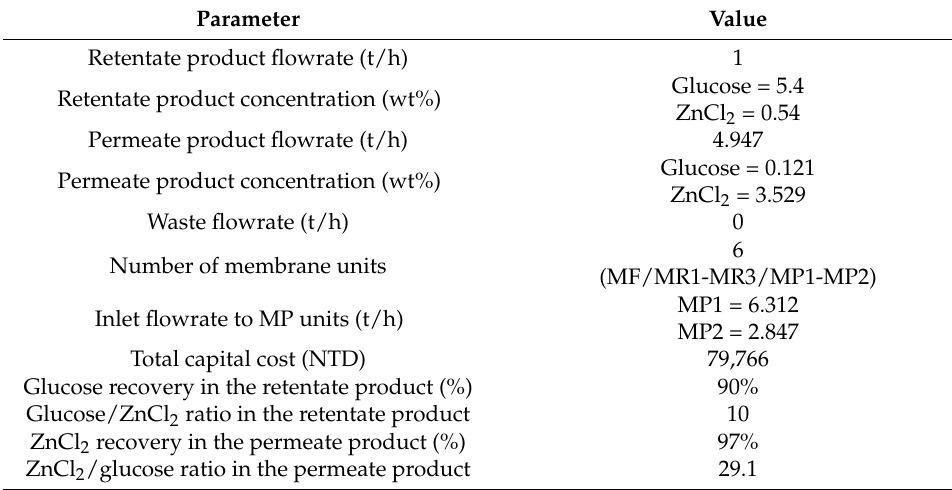
Table 5. Main results for case